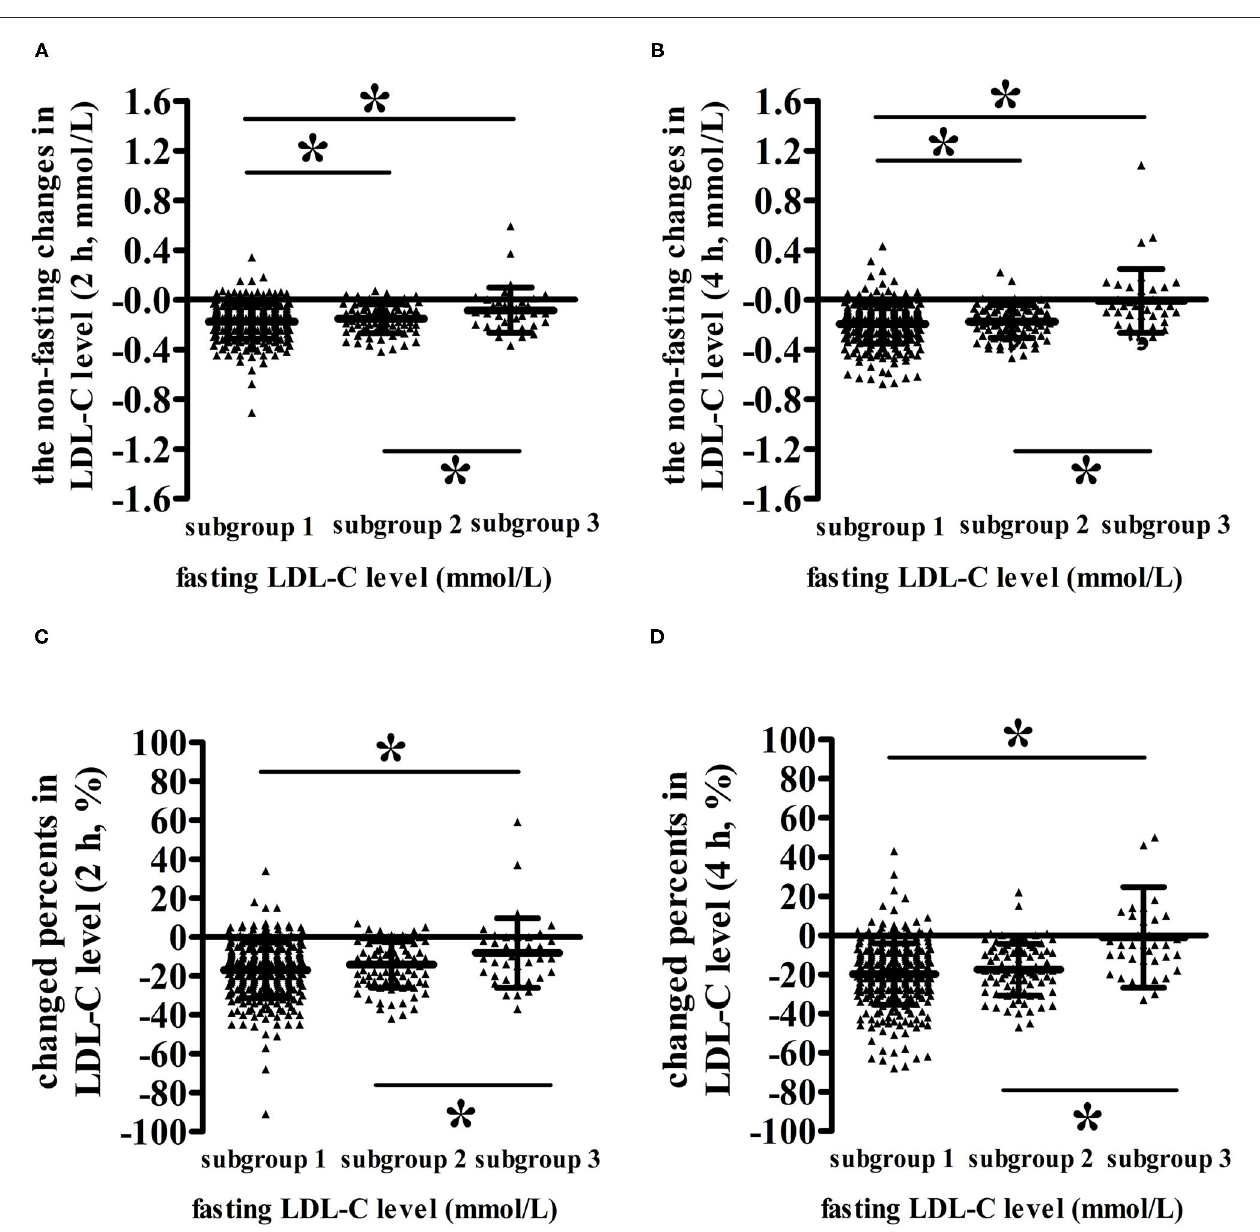
FIGURE 3 | Comparisons of the non-fasting changes and changed percents in LDL-C levels among patients with different fasting LDL-C levels after a daily breakfast. (A,B) Comparisons of the non-fasting changes of LDL-C levels among patients with different fasting LDL-C levels at 2 and 4h, respectively. (C,D) Comparisons of the non-fasting changed percents of LDL-C levels among patients with different fasting LDL-C levels at 2 and 4h, respectively. * P < 0.05 the difference between two subgroups reached statistical